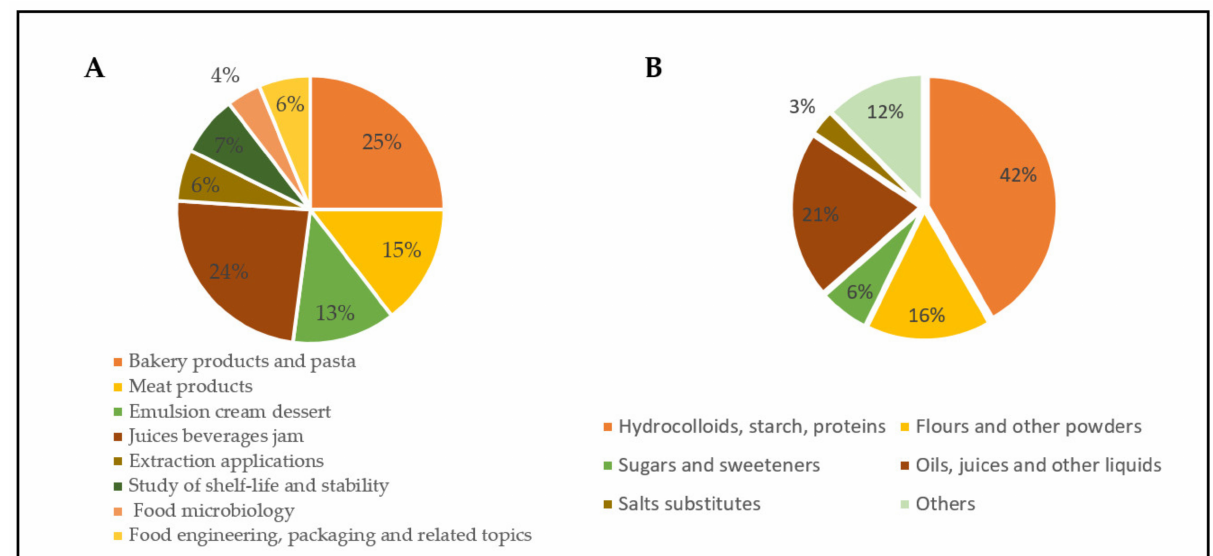
Figure 4. ( A ) Food products/applications and ( B ) type of components in the surveyed articles, respectively ( n = 96).